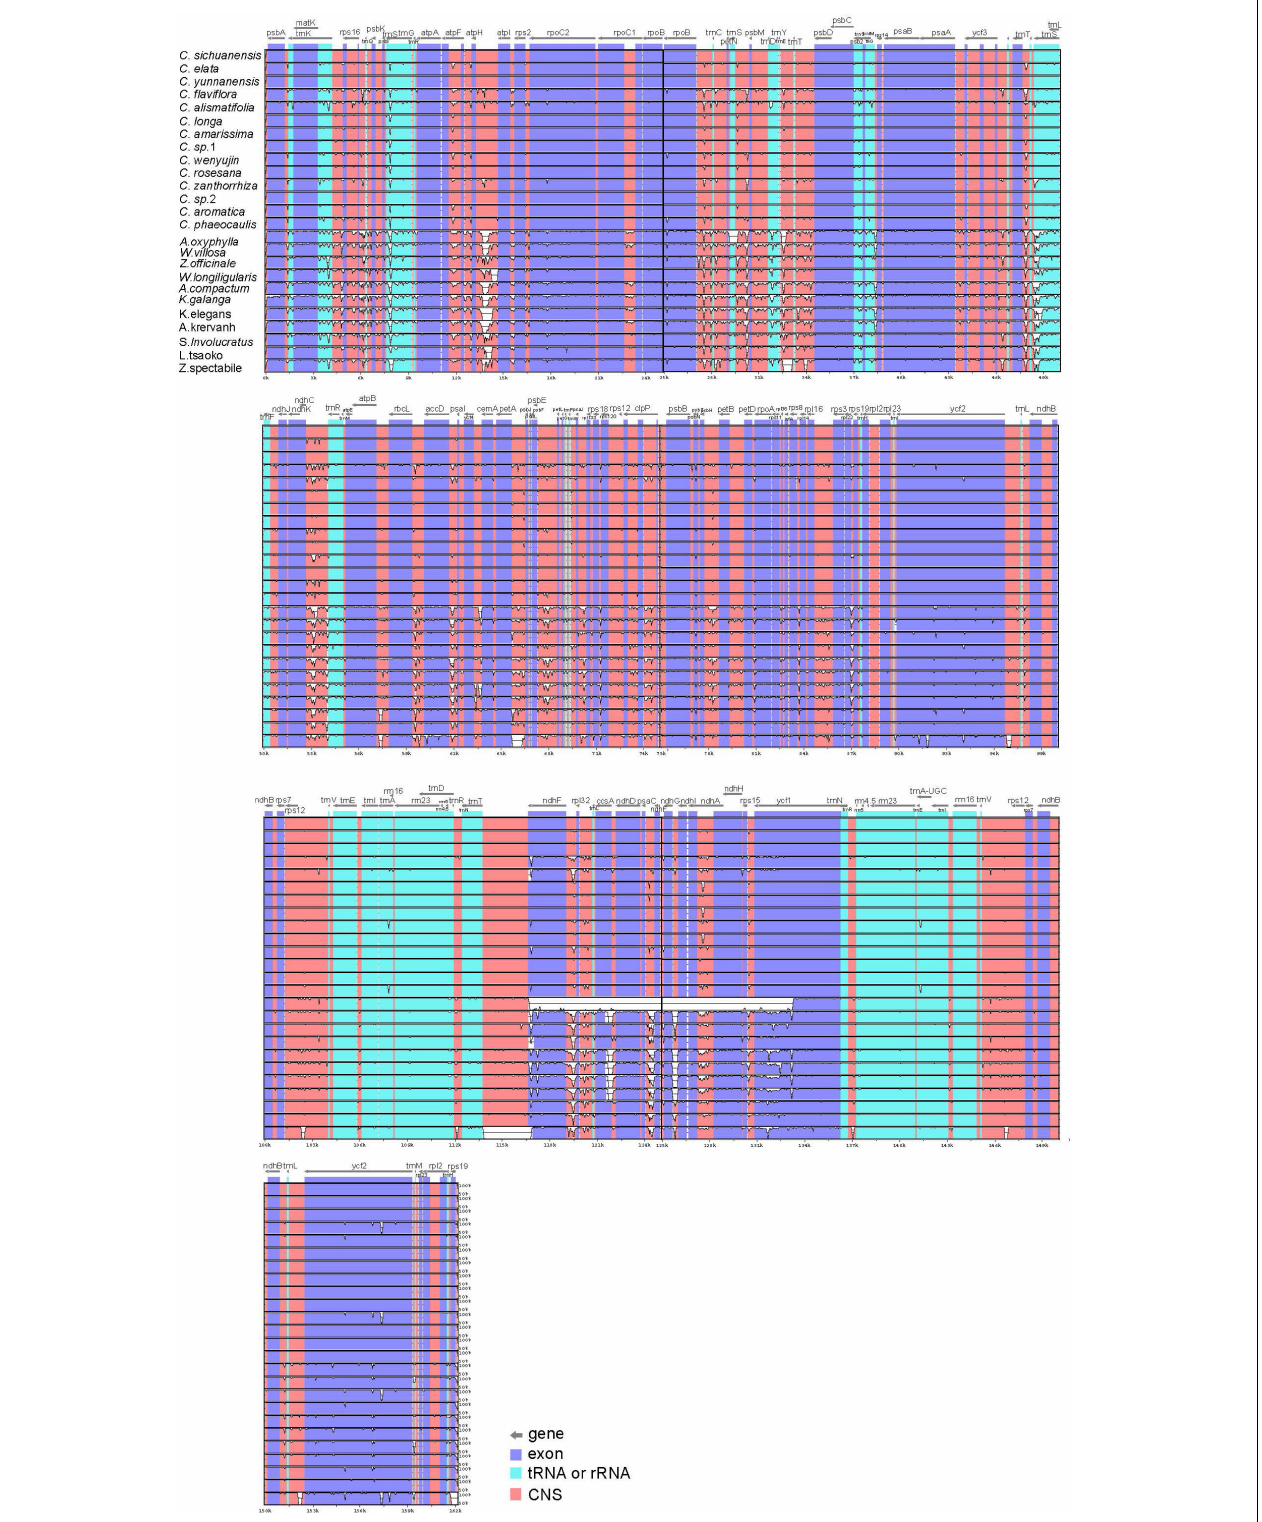
FIGURE 2 | Sequence alignment of 25 Zingiberaceae chloroplast genome with C. sichuanensis as a reference by using in mVISTA. The Y-scale represents the percentage of identity ranging from 50 to 100%.